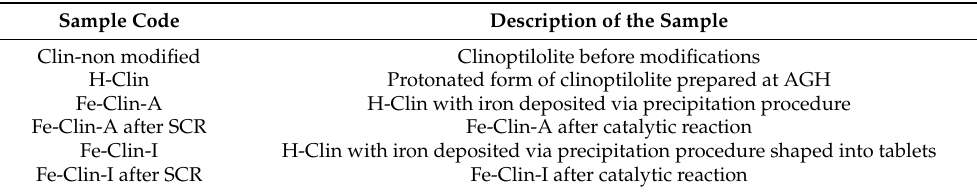
Table 4. The list of the studied samples with their codes and